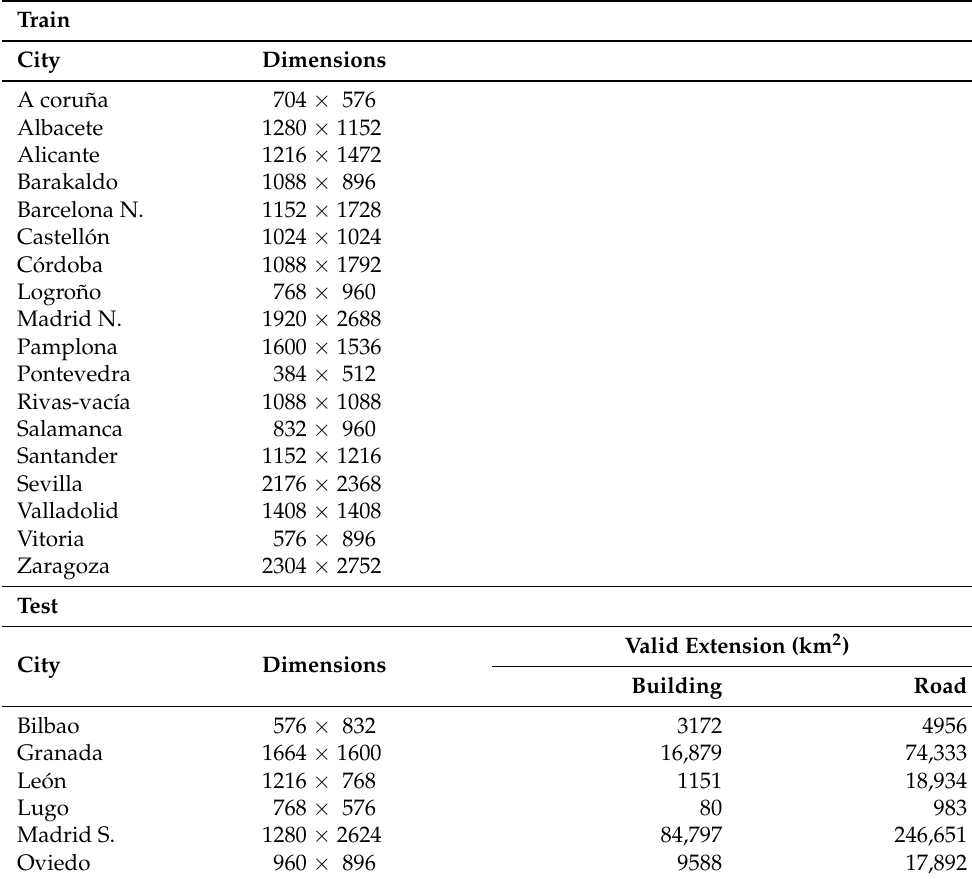
Table 1. Summary of the dataset. Overall, the training set is composed of 18 cities (75%), whereas the testing set consists of 6 cities